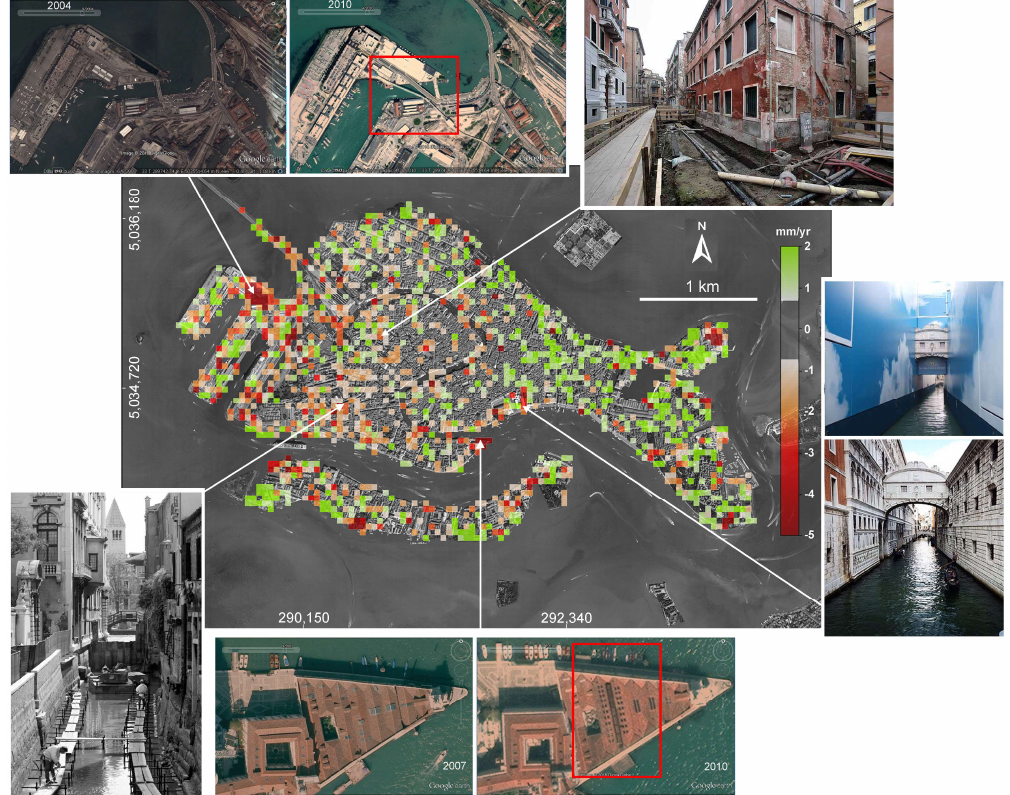
Figure 3. Map of the recent anthropogenic land movements at Venice as obtained by subtracting the ERS-ENVISAT long-term ground movements from the TerraSAR-X short-term ground movements, resampling the PSI solutions on a regular 50 m grid [18]. Negative and positive rates indicate areas where human activities are responsible for land settlements or reduce the natural subsidence, respectively. A few examples of human activities possibly influencing the subsidence values are shown in the photograph insets (available from http://www.insula.it/ and Google Earth Images). Finally, notice that because of the intrinsic properties of the TerraSAR-X images and satellite revisiting time, a one-year image stack is sufficient to provide an interferometric product